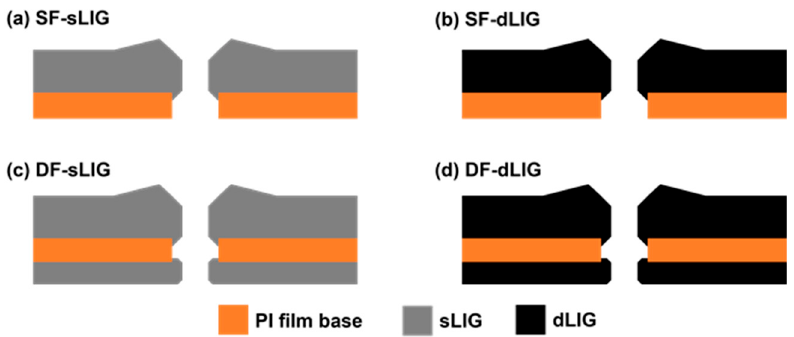
Figure 2. Cross-sectional schematics of different LIG filter types: ( a ) SF-sLIG, ( b ) SF-dLIG, ( c ) DF- sLIG, and ( d ) DF-dLIG. The different shades (gray and black) signify different densities of the generated LIG.